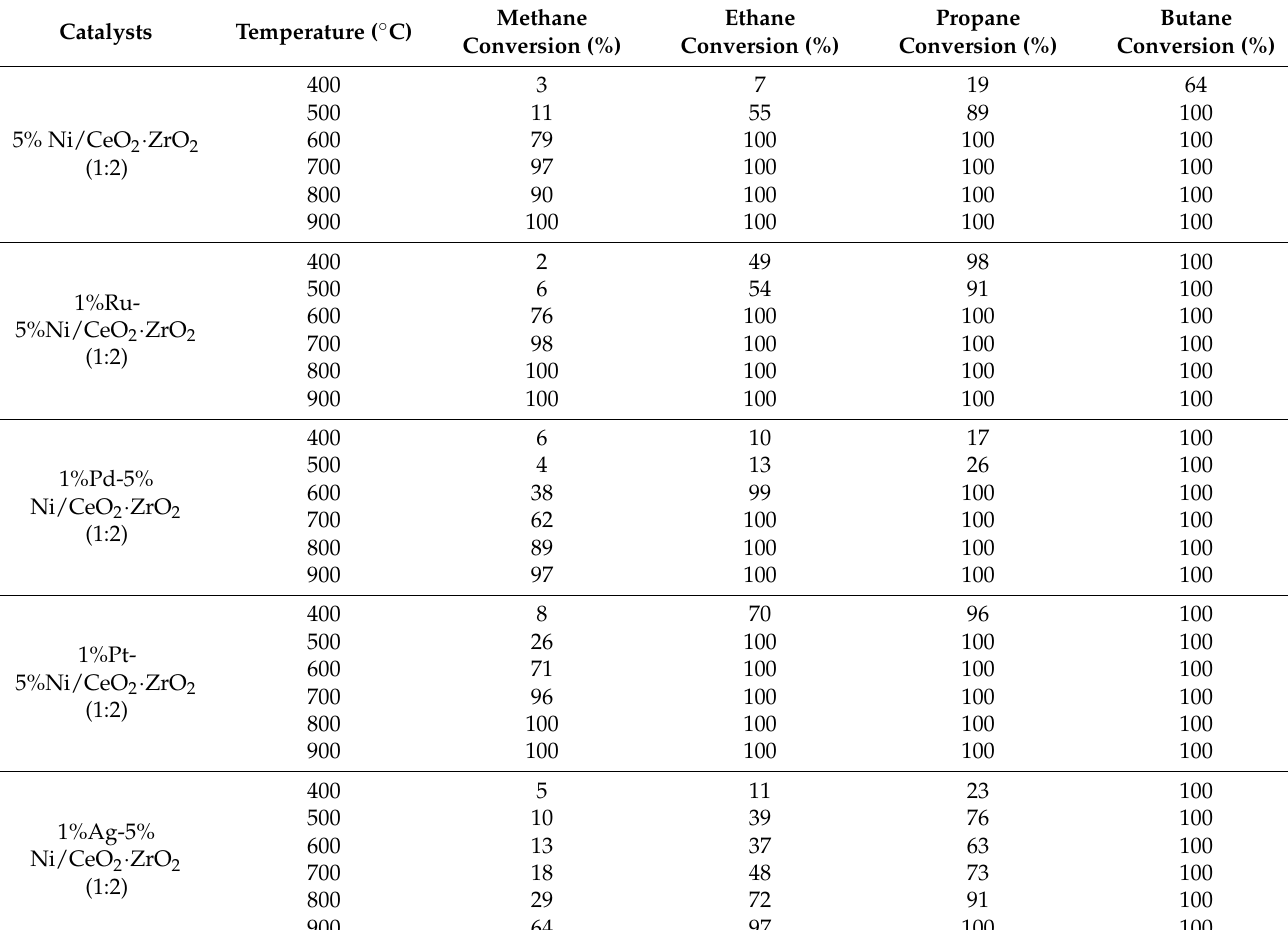
Table 1. Activity of mono- and bimetallic catalysts supported on CeO 2 · ZrO 2 (1:2) tested in OSR-LNG.